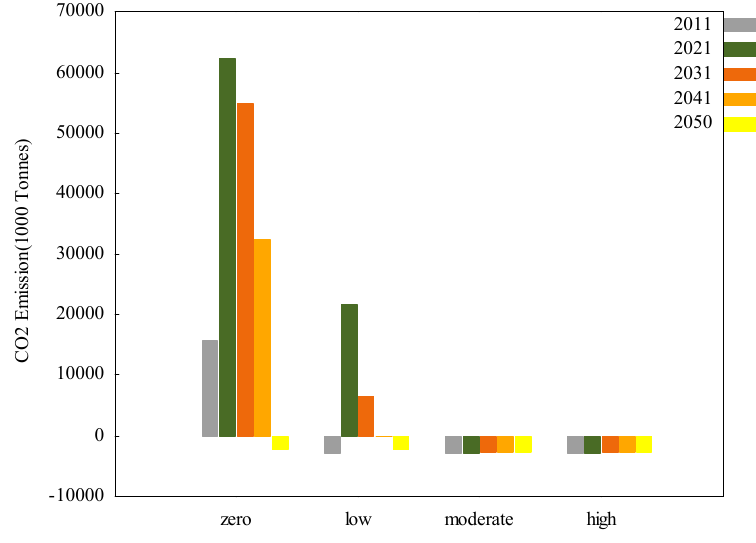
Figure 7. Total GHG emissions under no subsidy action.